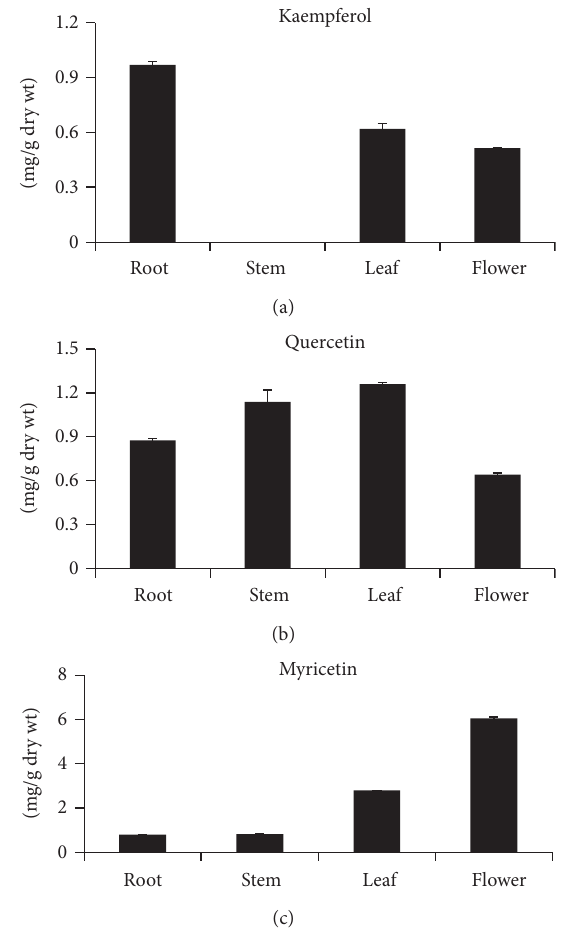
Figure 5: Flavonol content in different organs of S. baicalensis. The height of each bar and error bars represent the means and standard errors, respectively, from 3 independent